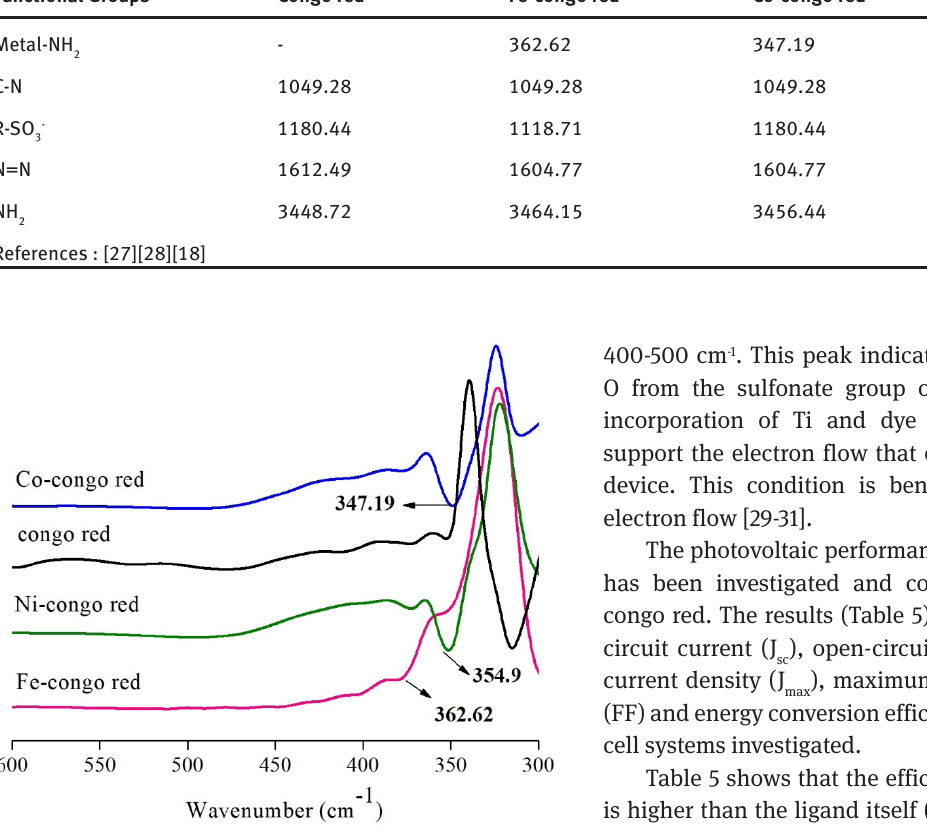
Table 4: The functional group and metal ligand bonding of congo red complexes. Functional Groups